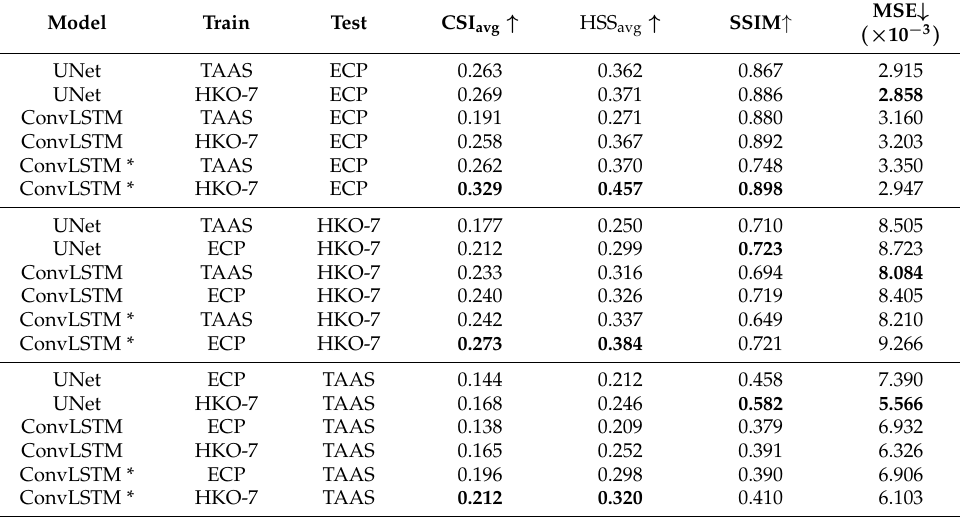
Table 8. Switching the training set and the testing set of three datasets. * stands for TSS + MIR.